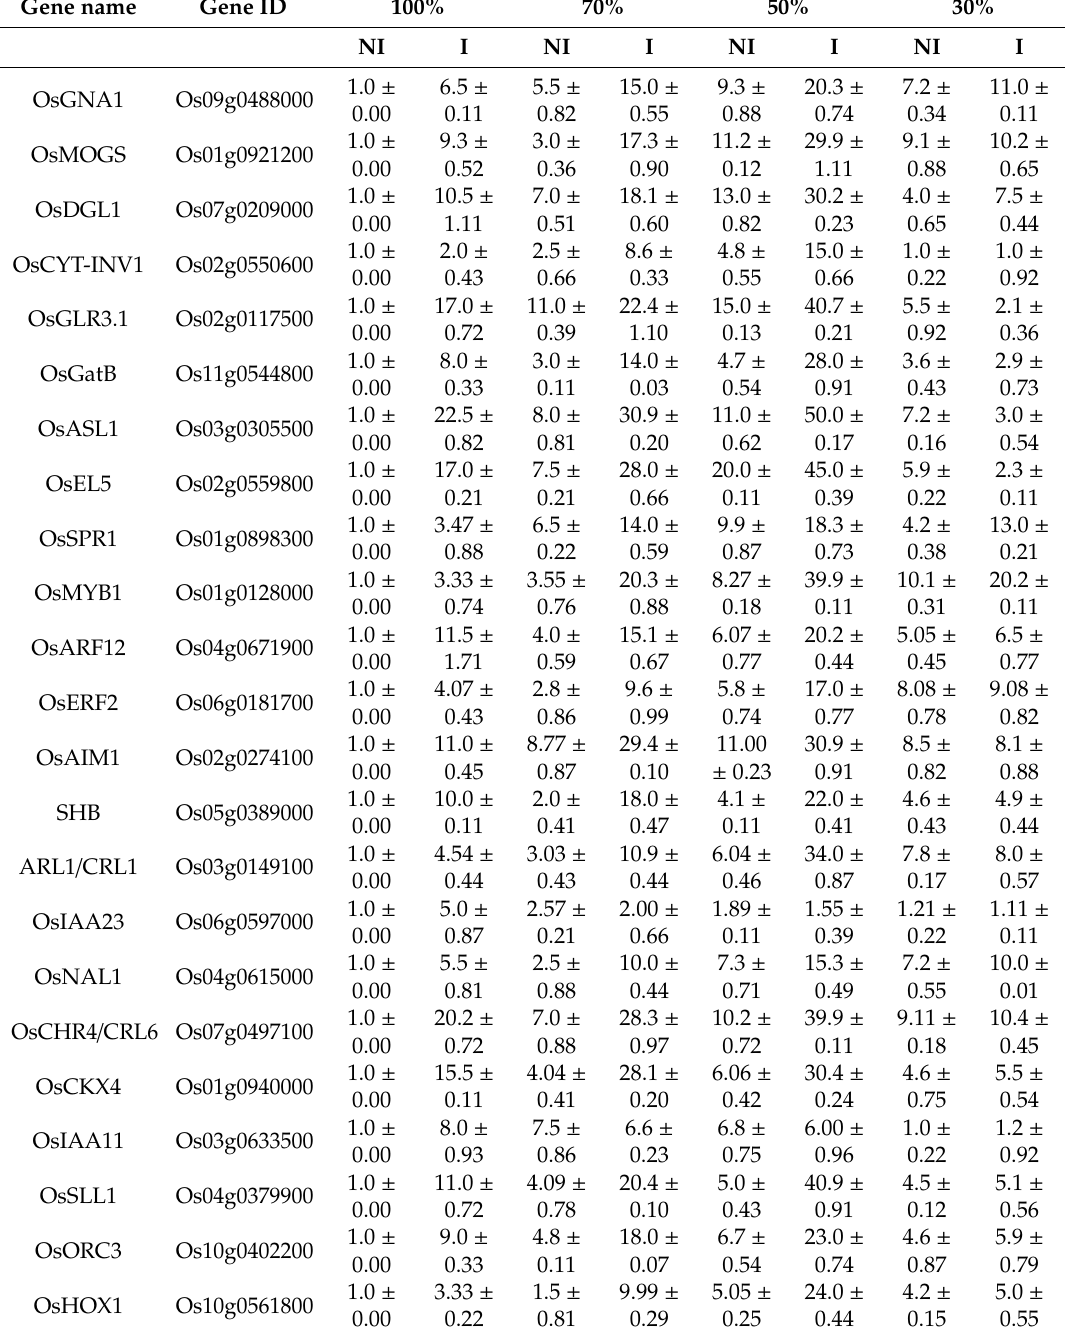
Table 2. RT-qPCR analysis of root growth and development of red rice genes during drought stress. Shown are the RT-qPCR results of the plants of red rice grown in the presence and absence of G. diazotrophicus strains Pal5, under water restriction. Mean values and standard errors were calculated from the results of the three replicates. Averages followed by identical capital letters do not di ff er in the inoculation condition for each soil water treatment, and averages followed by identical lowercase letters do not di ff er in the percentage of soil water. NI = Uninoculated and I =